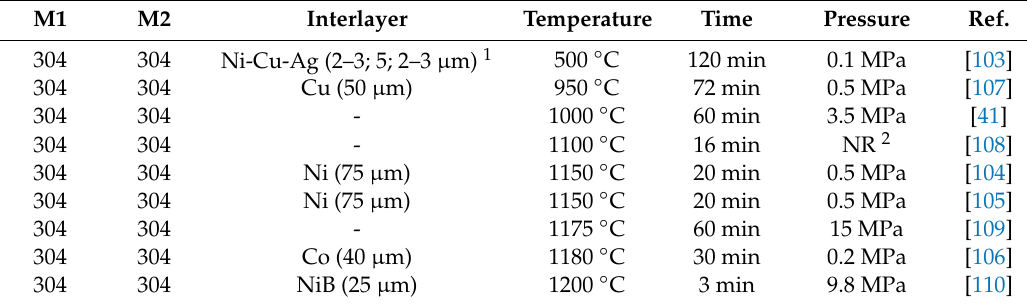
Table 2. Reported parameters for similar di ff usion bonding and TLP bonding of